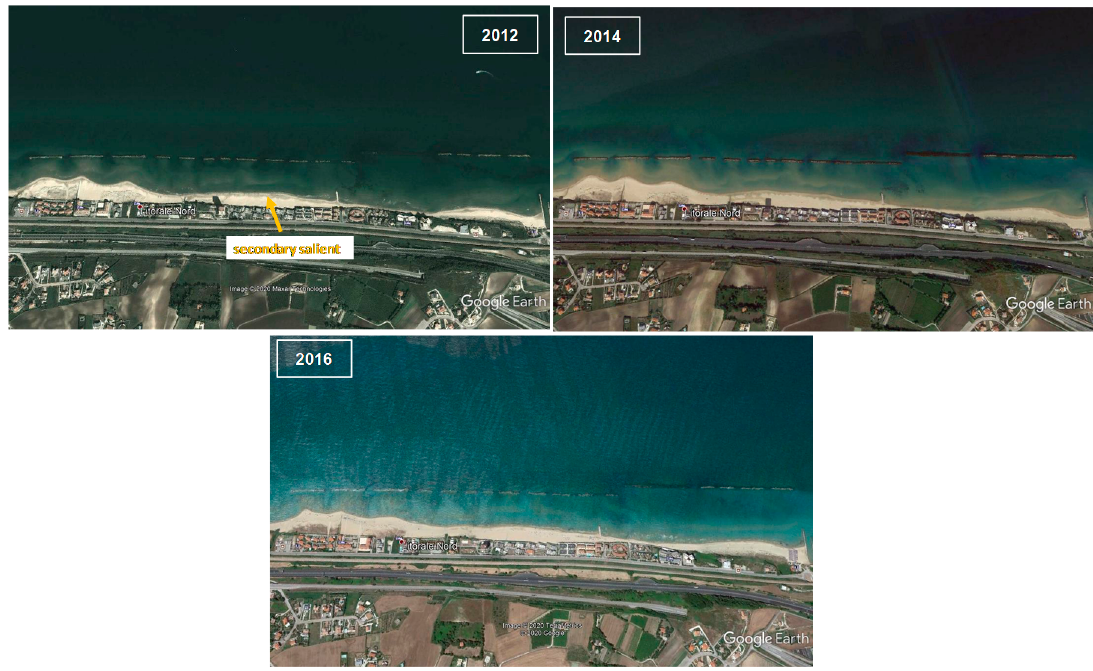
Figure 10. Shoreline planform at S A2 .